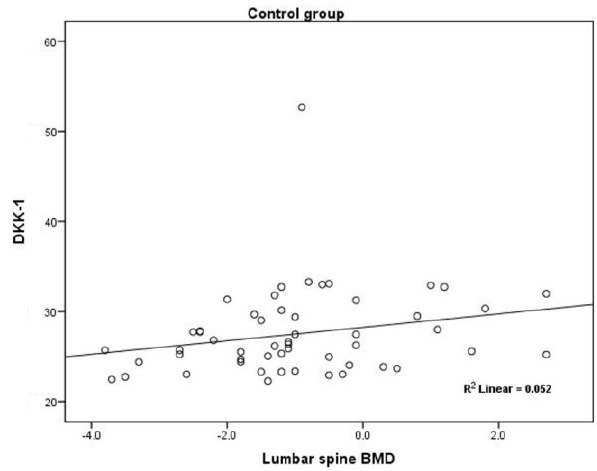
Figure 4. Positive Spearman’s Rho ( ρ ) correlation between serum DKK1 levels and lumbar spine T -Score (Rho = 0.291; p = 0.03).